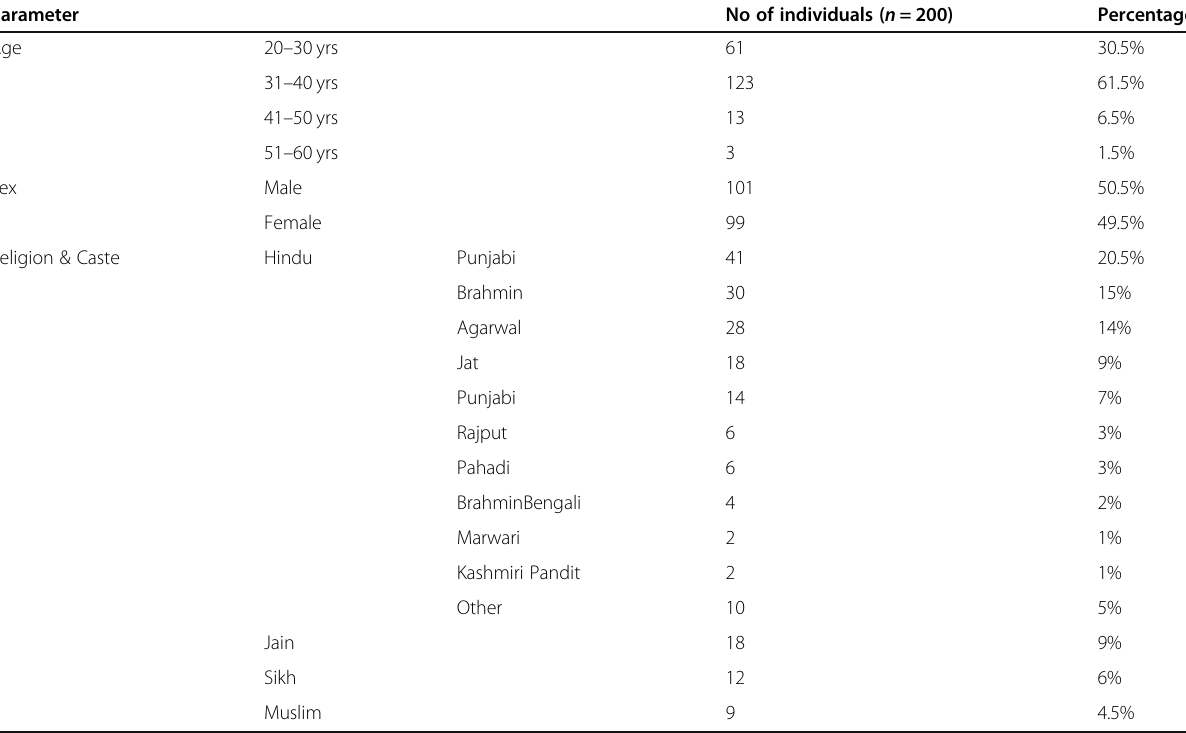
Table 1 Demographic characteristics of the individuals enrolled in the study